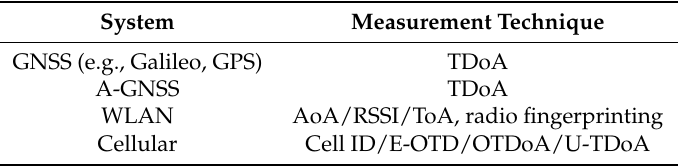
Table 1. Wireless positioning systems and corresponding measurement